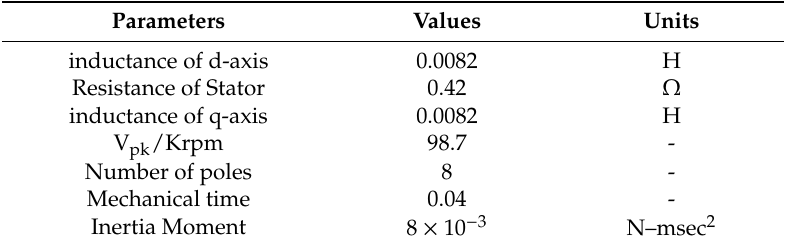
Table 3. Permanent magnet synchronous generator parameters.